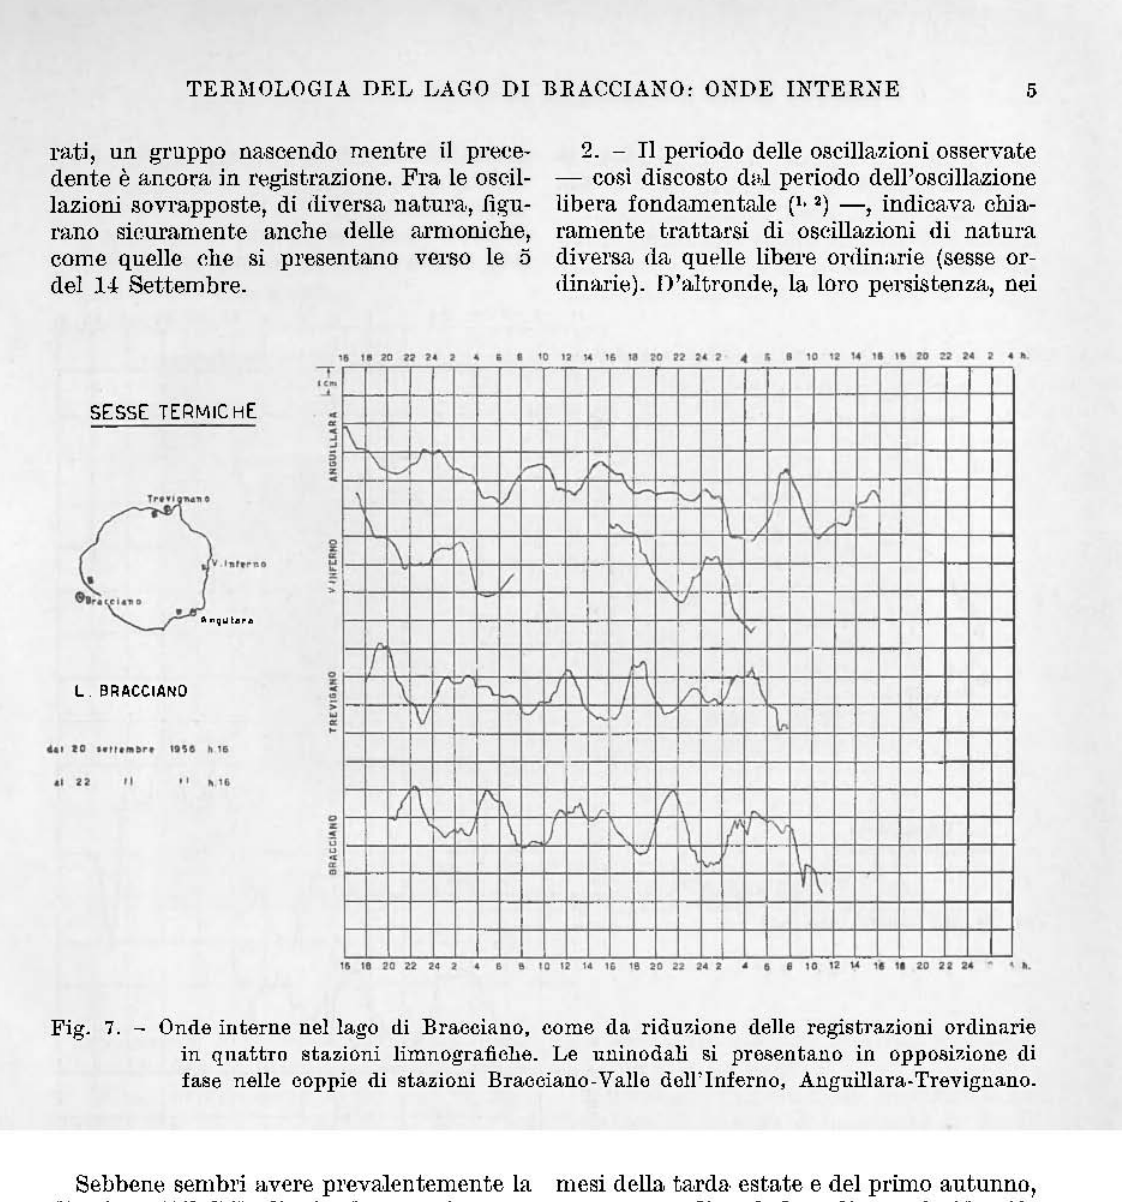
colari tipi di onde